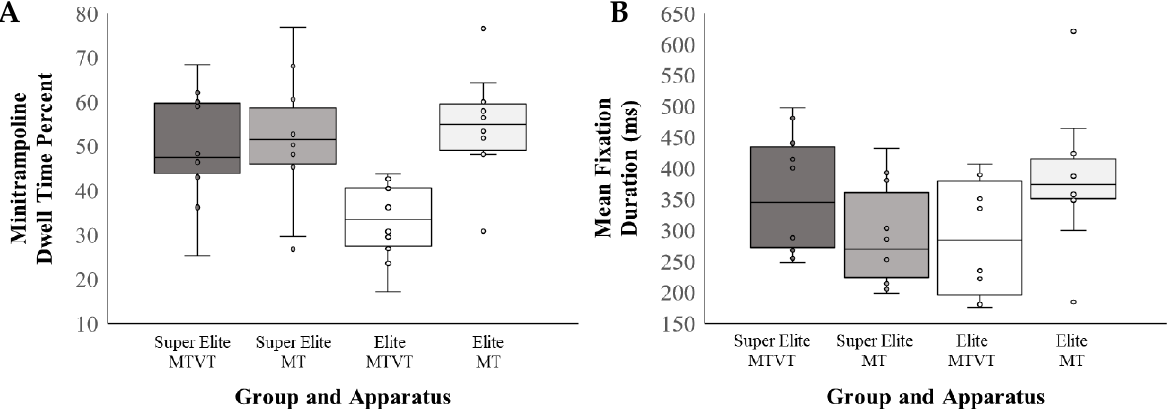
Figure 3. Gaze measures by group (super elite vs. elite) and apparatus (MTVT vs. MT): ( A ) dwell time percent on the mini-trampoline during the approach run, as a function of total fixation time; ( B ) mean fixation duration in milliseconds.